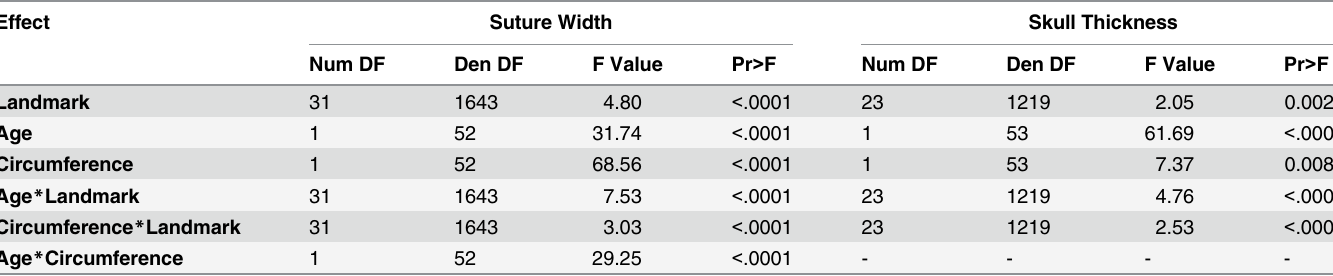
Table 1. Results from the linear mixed regression model.